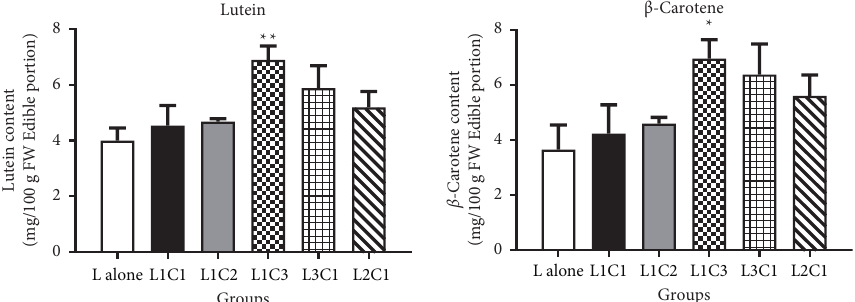
Figure 6: Effect of companion planting with chicory on carotenoid contents in lettuce grown in the indoor LED growth chamber for 25 days. Carotenoids were analyzed using an UPLC system (means ± SE, n � 3).